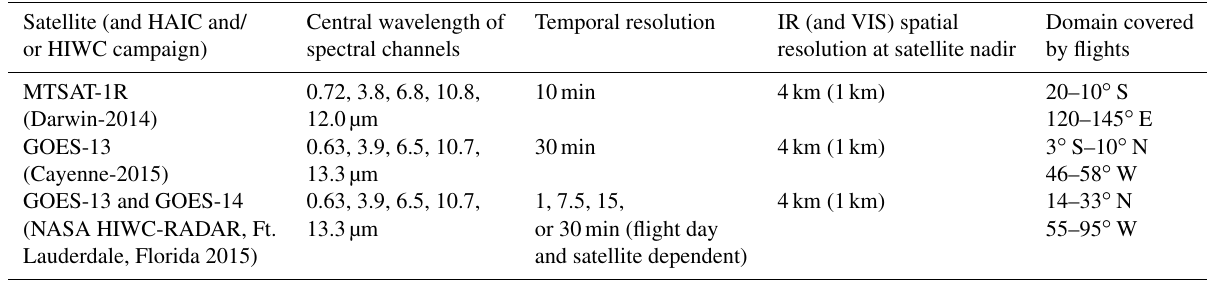
Table 1. The spectral channels, temporal and spatial resolution, of the two satellite imagers used in this study and the geographic bounds of the study